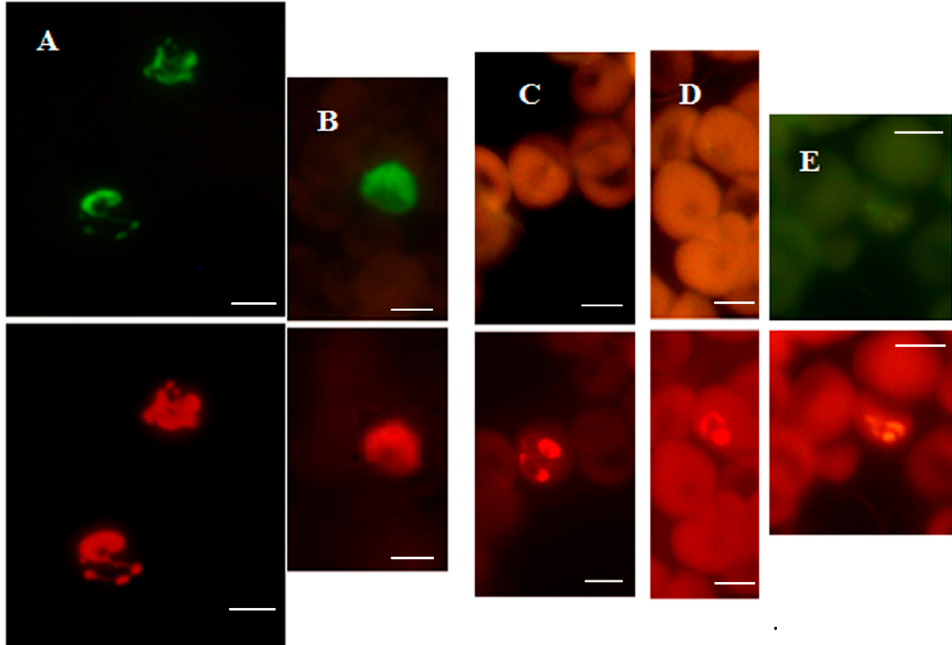
Figure 3. P. vivax -specific FISH test.Photographs showing PV-FISH test results on patient blood samples with independently confirmed malaria infections from Peru ( A ), India ( B ) and Kenya ( C – E ). Patient blood positive for ( A , B ) P. vivax ; ( C ) P. ovale ; ( D ) P. malariae ; ( E ) P. falciparum . Green and red fluorescence are due to hybridization with the P. vivax -specific probe and Plasmodium genus-specific probe, respectively, in the same field when viewed with appropriate light filters. The scale bars represent approximately 5 µm. Figure reproduced with permission under the creative commons license from Reference [39].